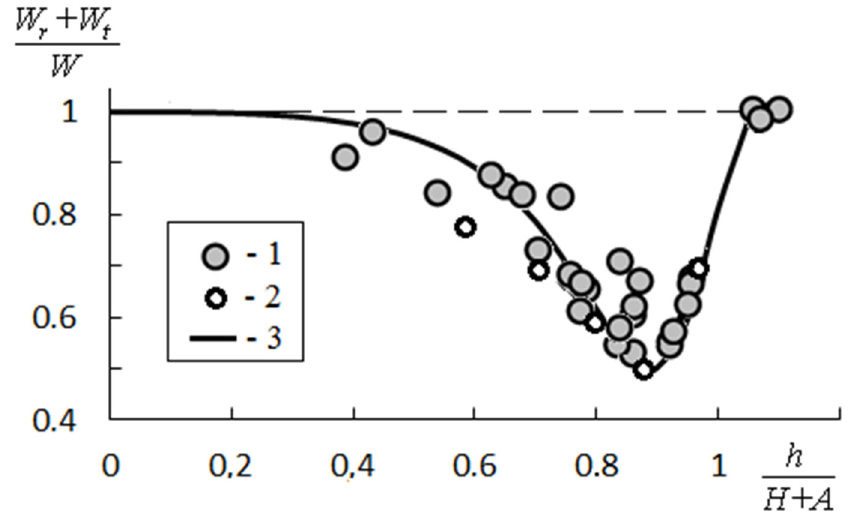
Figure 12. The sum of the relative energies of the waves reflected and transmitted through the barrier as a function of the generalized parameter of the barrier height: 1—experiments; 2—numerical experiment based on f Equations; 3—calculations by author’s theory at Н = 0.103 m, А = 0.007 m, and k = 0.68.